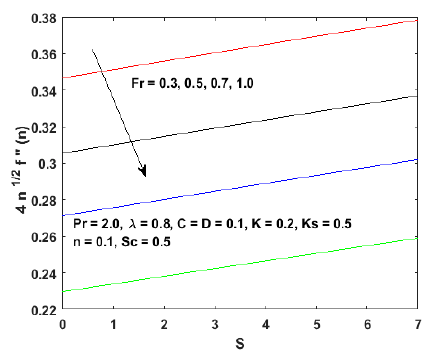
Figure 12. Effect of S and F r on 4 n 1/2 f (cid:48)(cid:48) ( n ) .